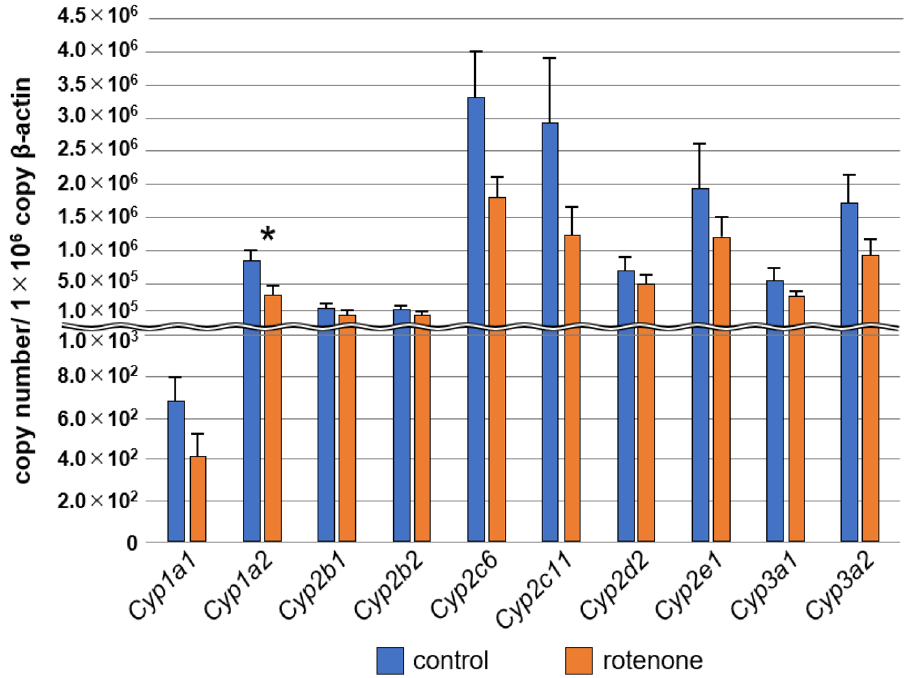
Figure 2. Transcriptional analysis of the P450 genes in rotenone-administered rats and a control rat. Total RNA was isolated from livers recovered from control rats (n = 7) and rotenone-administered rats (n = 10). Expression levels of each P450 were evaluated via quantitative polymerase chain reaction. Copy numbers of each P450 per 10 6 b-actin copies are presented as the mean ± standard error of the mean. Significant differences were evaluated via Welch’s t-test (* P <